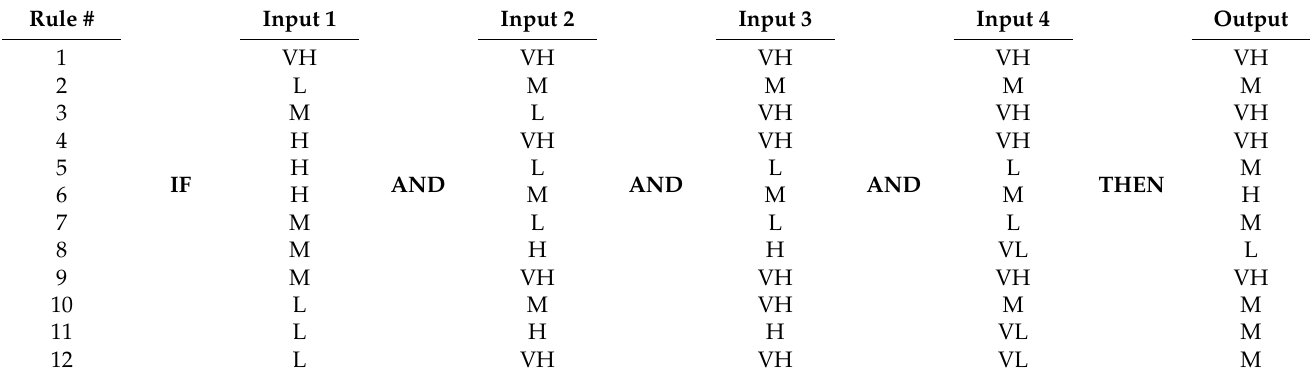
Table 5. The fuzzy rules (VH—Very High, H—High, M—Moderate, L—Low, VL—Very Low).